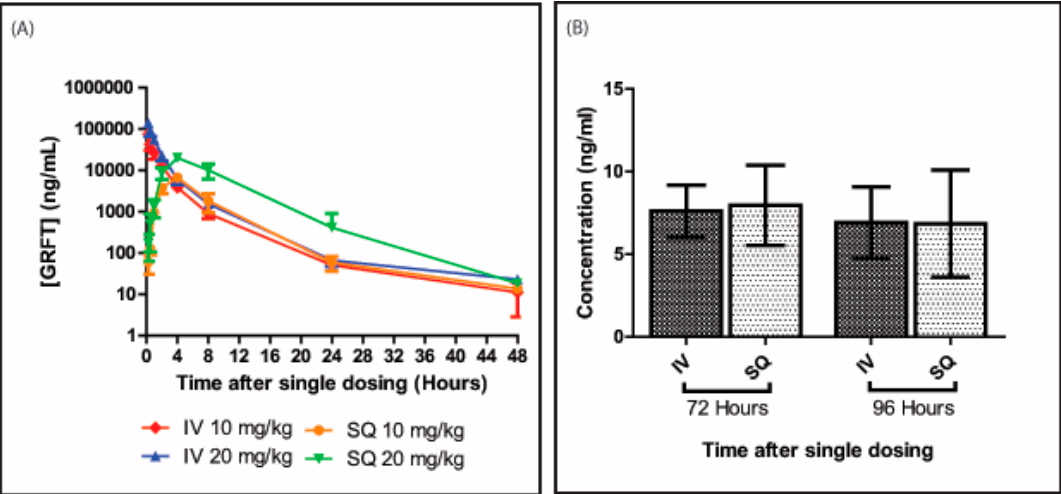
Figure 1. Pharmacokinetic profile of GRFT. Mean serum GRFT concentrations after single intravenous (IV) or subcutaneous (SQ) administration (n = 3–4 per group) ( A ). Serum GRFT amounts in animals dosed with 10 mg/kg were assessed at both 72 and 96 h post-administration ( B ). Bars are mean ± standard deviation from five biological replicates.